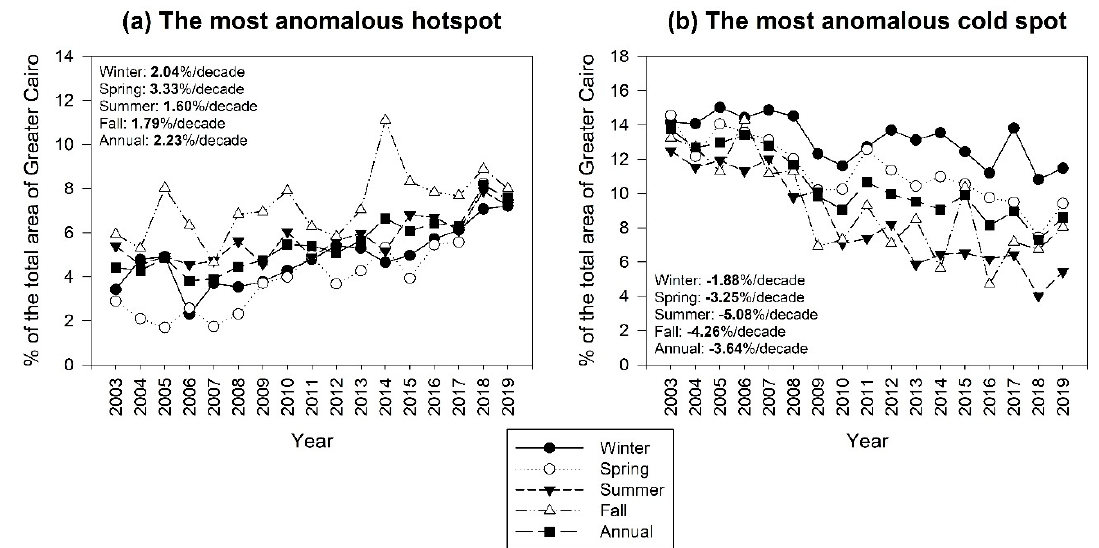
Figure 4. Seasonal and annual variability of the total area of the most anomalous hot (panel a ) and cold spot (panel b ) between 2003 and 2019, as compared to the total area of Greater Cairo. Amount of change in the total areas of both spots is provided; only numbers given in bold are statistically significant at the 95% confidence interval ( p < 0.05).